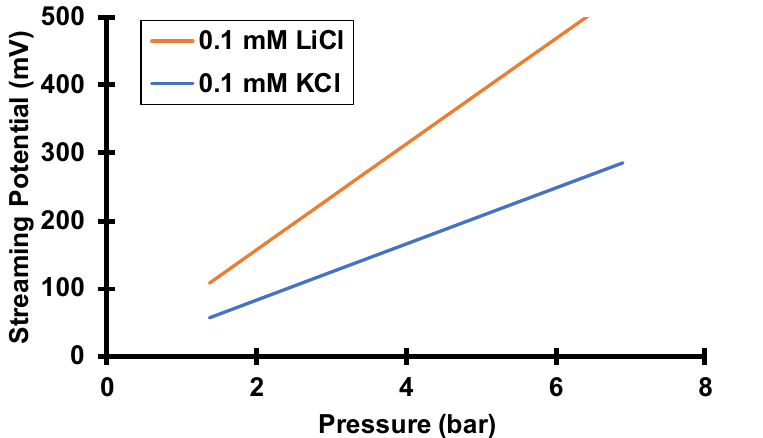
Figure 8. Simulated streaming potentials as a function of transmembrane pressure with either 0.1 mM KCl or 0.1 mM LiCl feed solutions passing through 30 nm pores at different transmembrane pressures. The simulation assumes a surface charge density of − 2.2 mC/m 2 and a boundary layer thickness of 19.4 µm, as estimated from the Levich equation for a rotation rate of 1000 rpm.